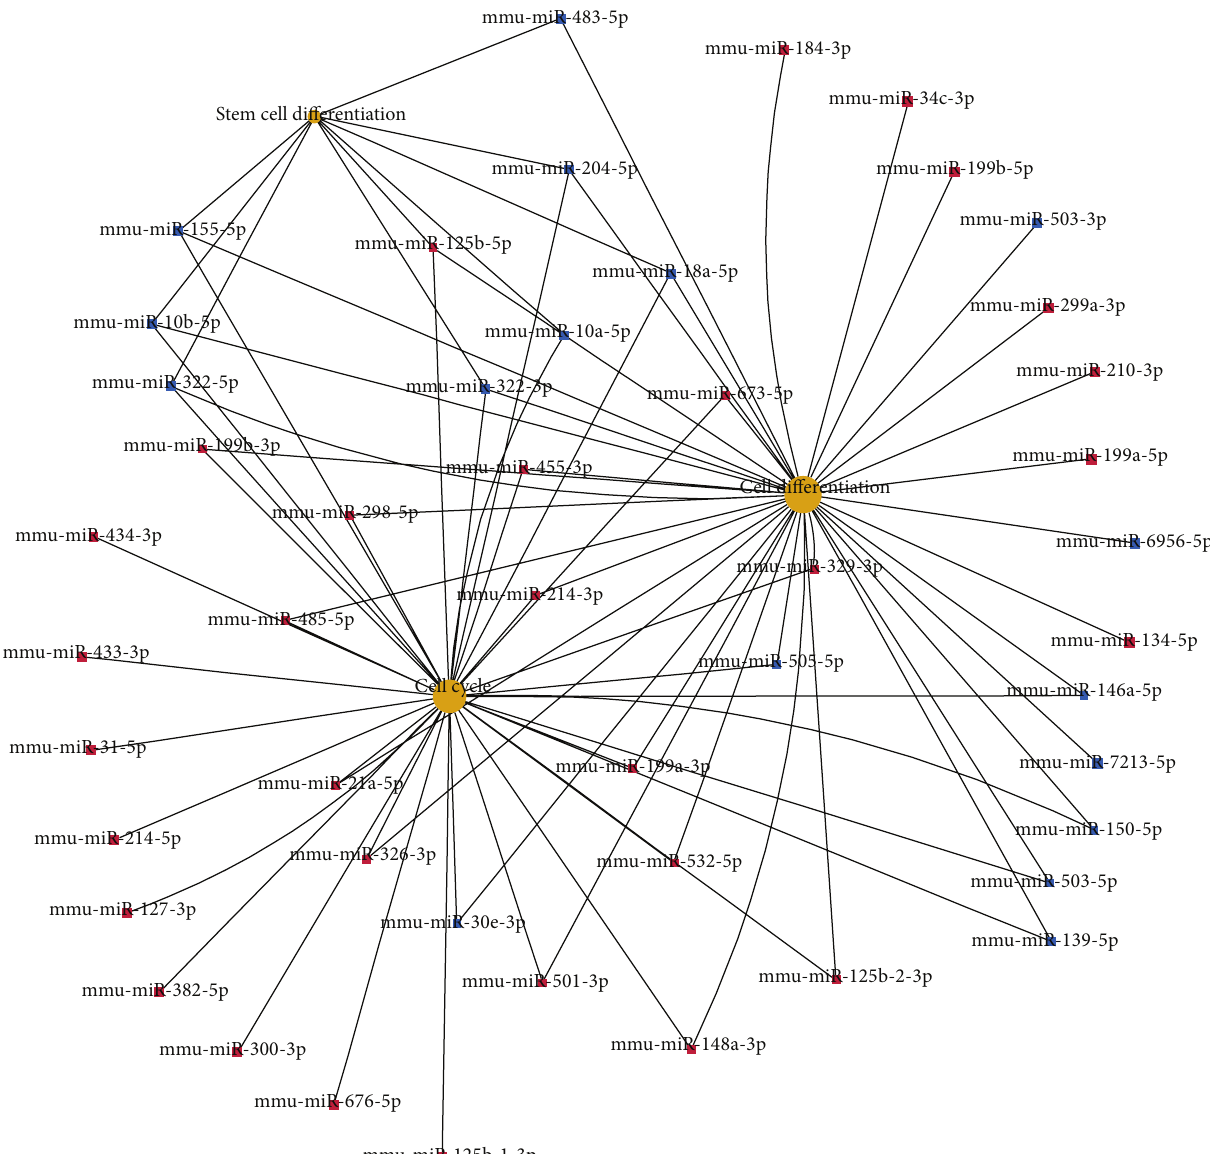
Figure 3: Differentially expressed miRNA and cell cycle and stem cell differentiation. Red: increased expression in Sca-1 + CD31 − compared to Sca-1 + CD31 + cell; blue: decreased